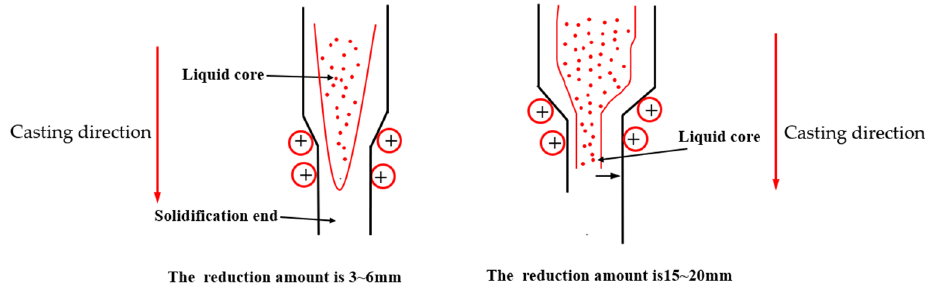
Figure 2. The minimum SR at the solidification end ( left ); the liquid core reduction ( right ).